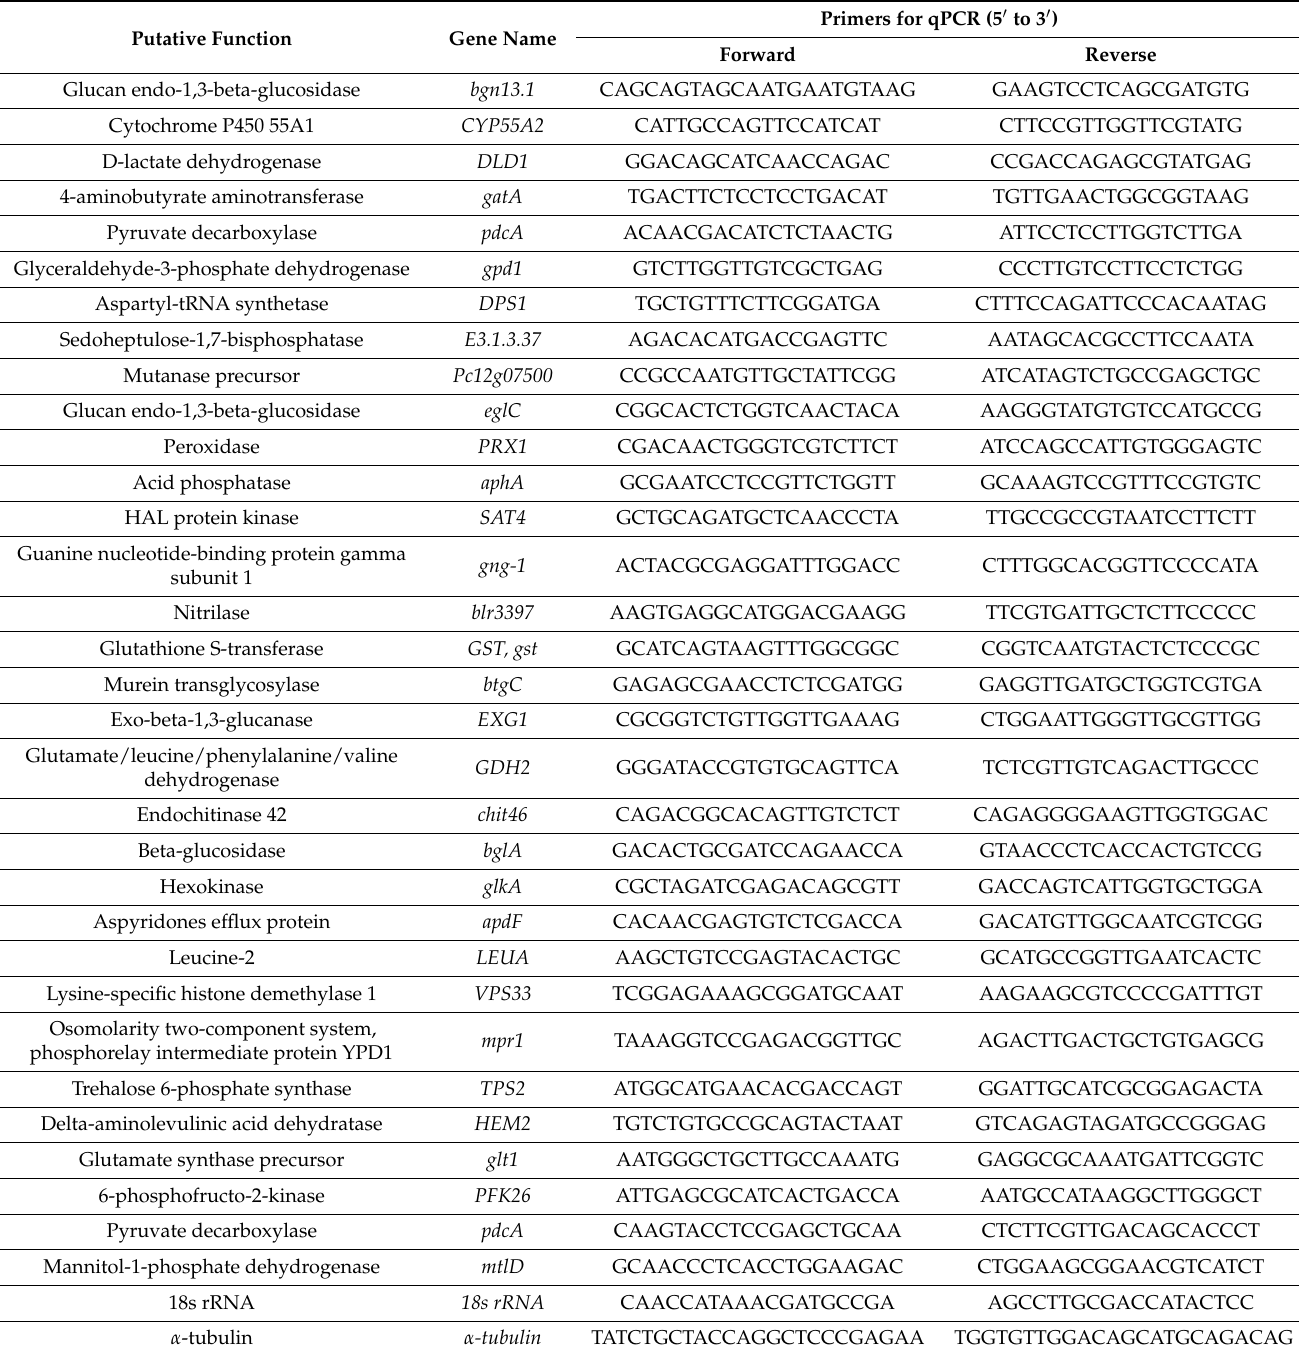
Table 1. Primer design for RT-qPCR validation experiments in T. harzianum